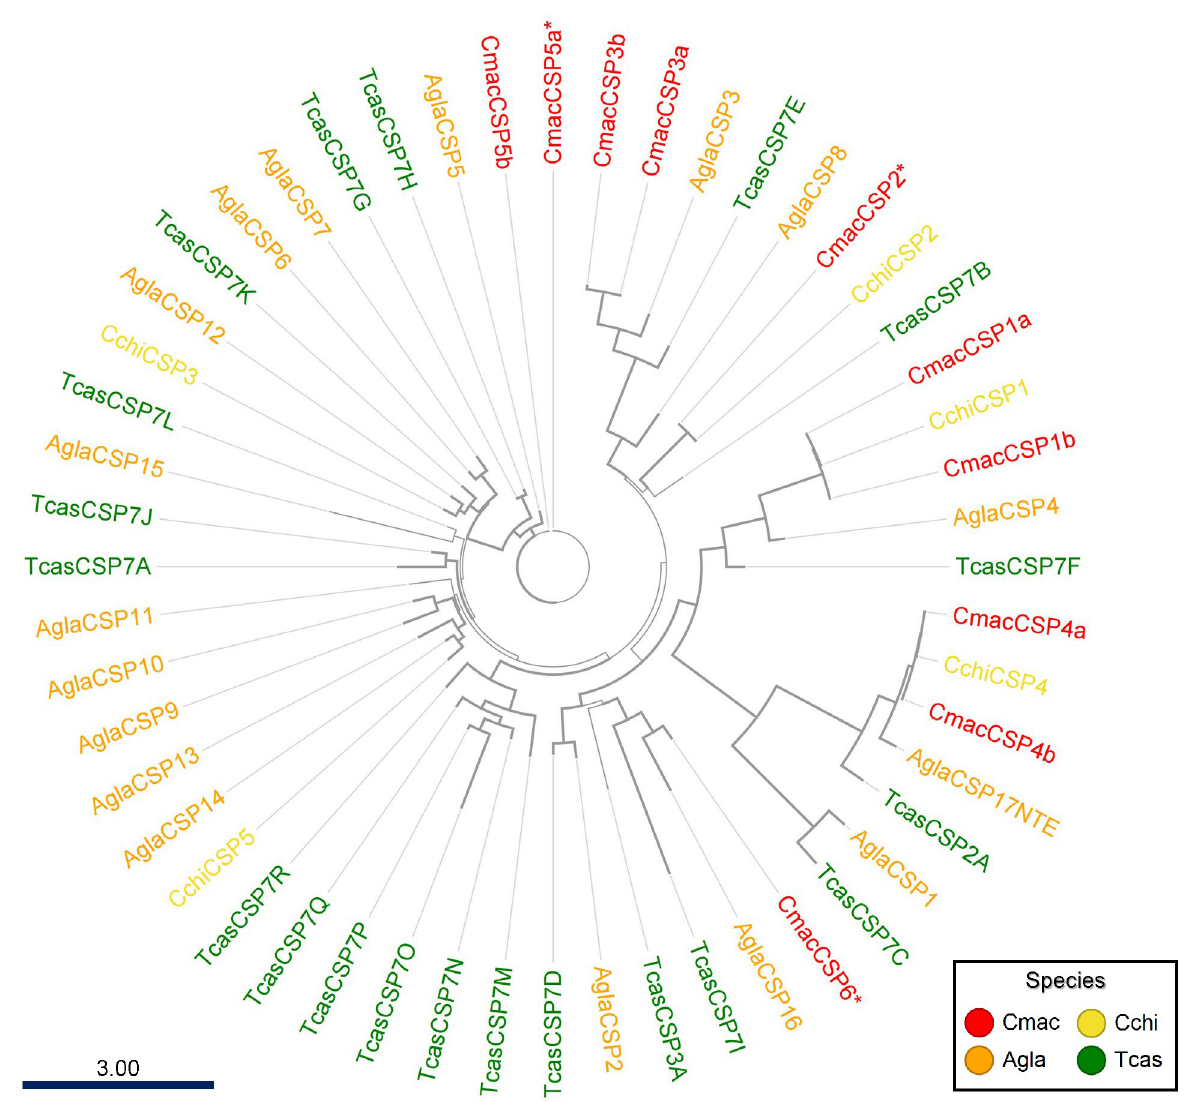
Fig 6. Maximum-likelihood phylogenetic tree of putative Callosobruchus maculatus chemosensory proteins (CSPs) with insect CSP sequences from Anoplophora glabripennis (Agla), Tribolium castaneum (Tcas), and Callosobruchus chinensis (Cchi). Thick nodes are supported by a bootstrap value > 60%. The rate of amino-acid substitutions per site is shown in the scale bar. The three CmacCSPs suffixed with asterisks were a perfect match between the antennal transcriptome and genomic analyses.